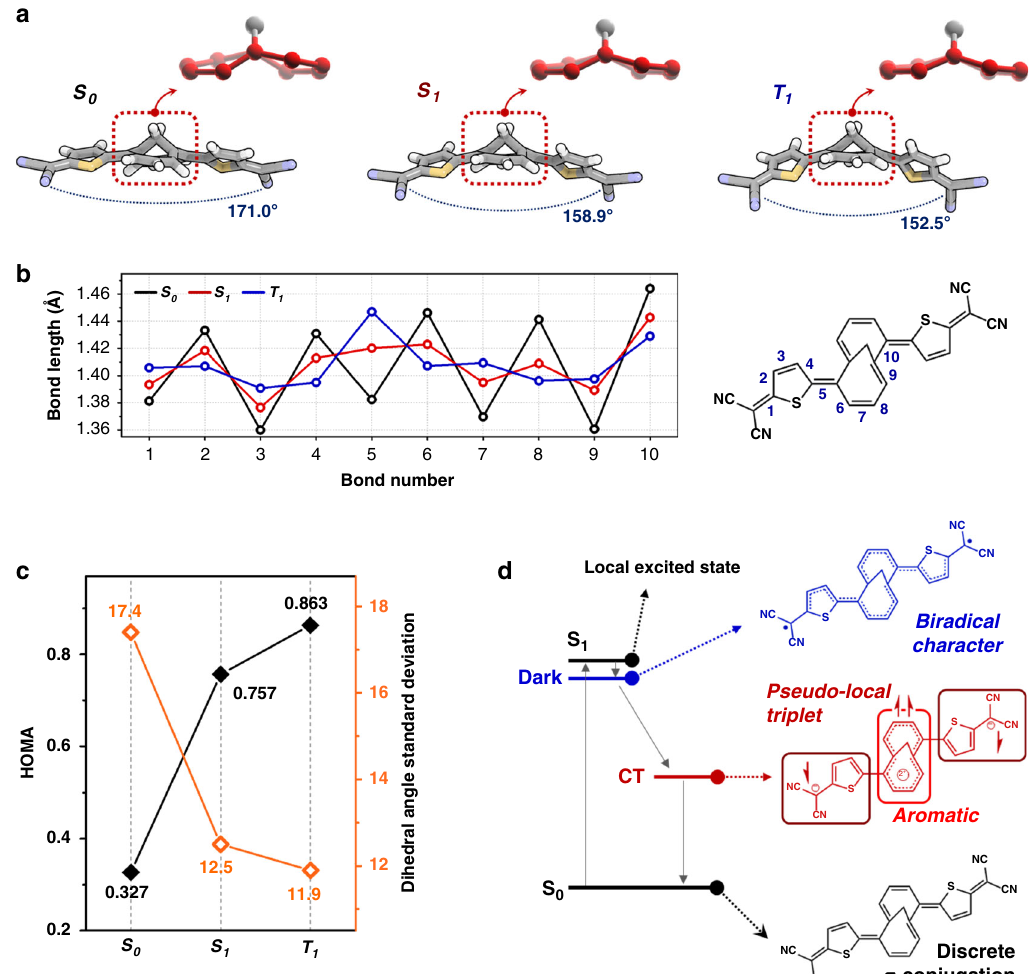
Fig. 4 Excited-state dynamics and conformation analyses. a The (TD)DFT-based optimized structure of TMTQ in the S 0 , S 1 , and T 1 states. The core annulene is colored as red. b The carbon – carbon bond length plot for TMTQ. The molecular structure is drawn based on the bond length distribution in the S 0 state. c The plot for HOMA and dihedral angle standard deviation values of core annulene. d Schematic illustration for the electronic structures and excited-state